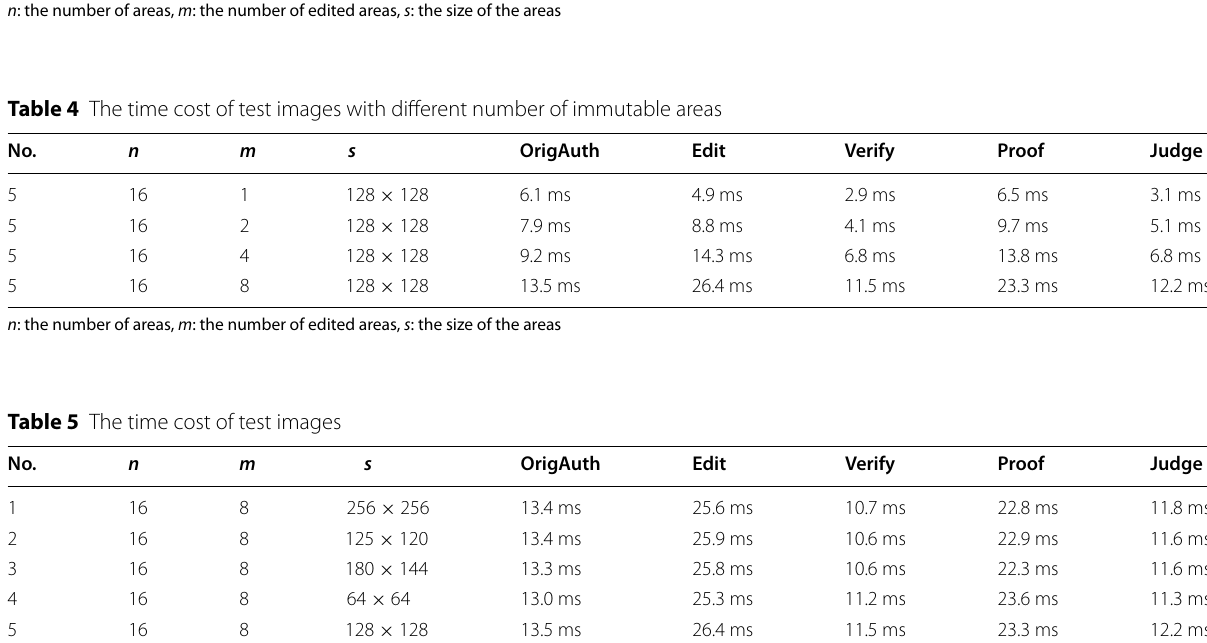
n : the number of areas, m : the number of edited areas, s : the size of the areas